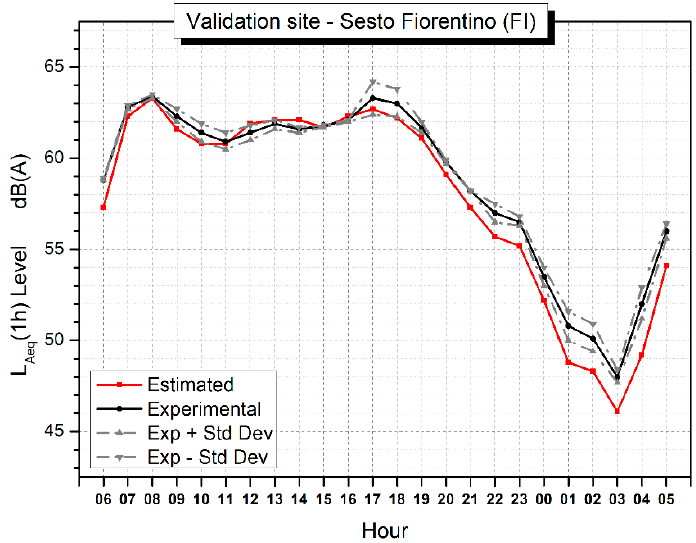
Figure 7. U-SPB L Aeq,h model and measured L Aeq,h comparison in V. The comparison of noise equivalent level indicators estimated with measurement